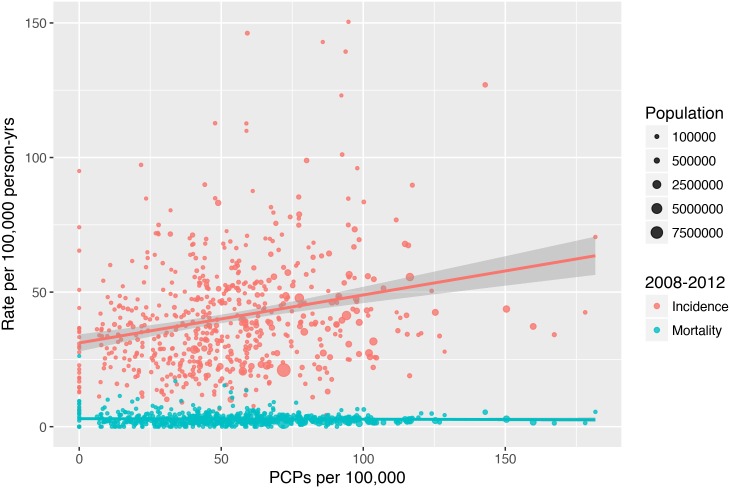
Total incidence and mortality as a function of PCP density.Melanoma incidence per 100,000 person-years and melanoma-specific mortality per 100,000 person-years as a function of PCPs per 100,000 people across all US counties in SEER from 2008–2012. Points are scaled in size by total county population, and the 95% CI for each line of fit is shown in gray.